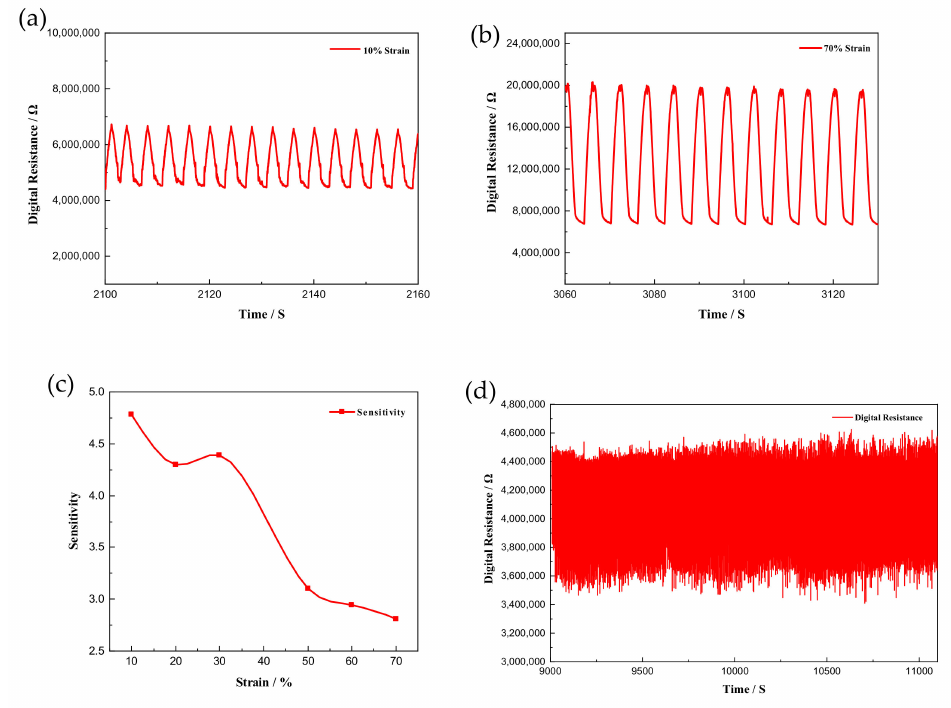
Figure 13. ( a ) Changes in the cyclic tensile resistance with time under 10% strain; ( b ) changes in the cyclic tensile resistance with time under 70% strain; ( c ) changes in the sensitivity with strain; ( d ) 70% strain-extension cycle test